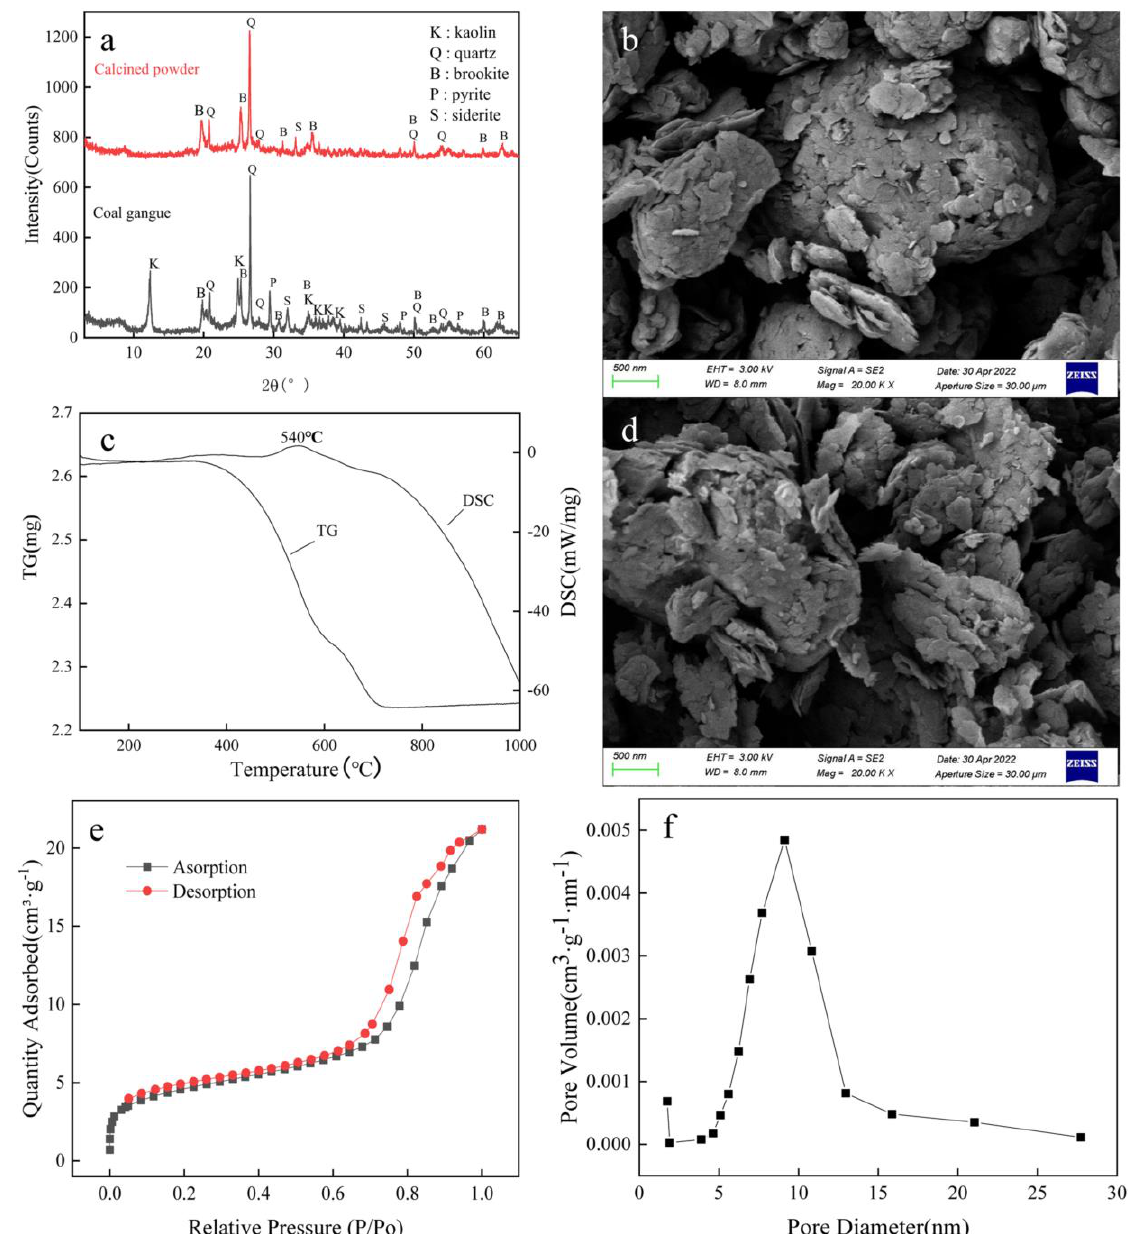
Figure 2. Characterization of gangue and its calcined powder. ( a ) is the XRD spectra of gangue and its calcined powder, ( b ) is the SEM diagram of raw gangue, ( c ) is the TG-DSC diagram of gangue, ( d ) is the SEM diagram of calcined powder, ( e ) is the nitrogen adsorption-desorption diagram of calcined powder, and ( f ) is the pore volume—pore size relationship of calcined